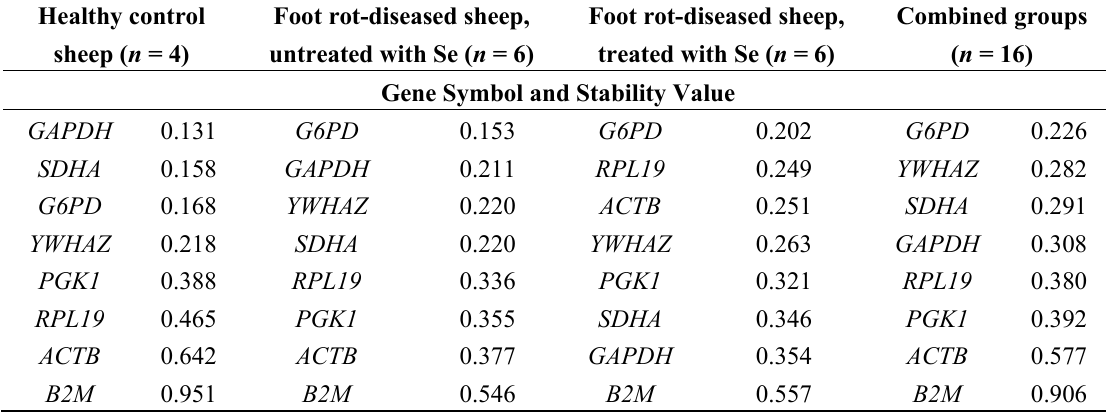
Table 5. Stability ranking of candidate reference genes in healthy control and foot rot-affected sheep, with or without selenium (Se) treatment, and in combined groups, by the BestKeeper algorithm (lower stability values indicate more stable gene